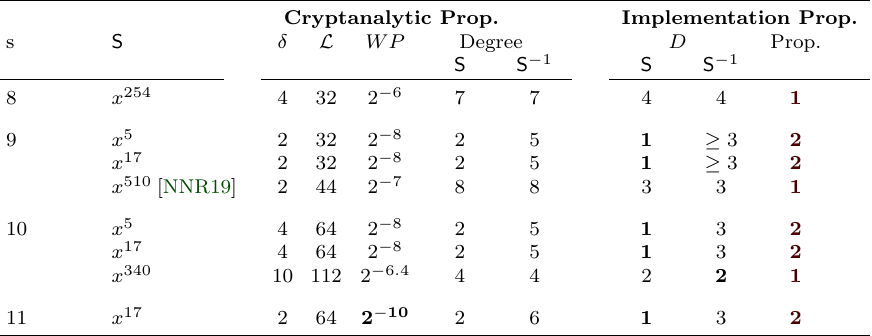
Table 7: Low-depth 8- to 11-bit S-boxes Overview Cryptanalytic